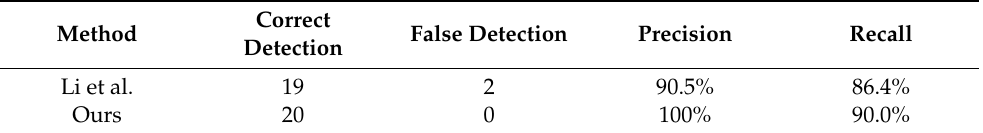
Table 3. Performance statistics of different methods.